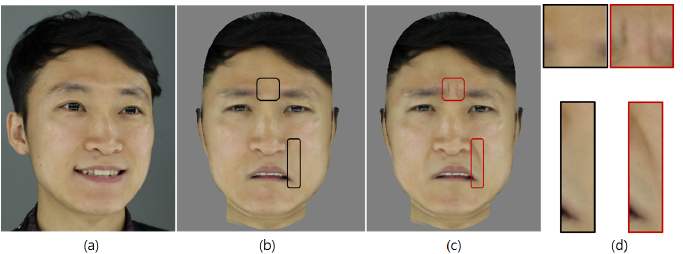
Figure 15. Wrinkle synthesis results: ( a ) Input face. ( b ) Target expression after expression neutralization. ( c ) Synthesized wrinkles in target face. ( d ) Synthesized wrinkles (red boxes).